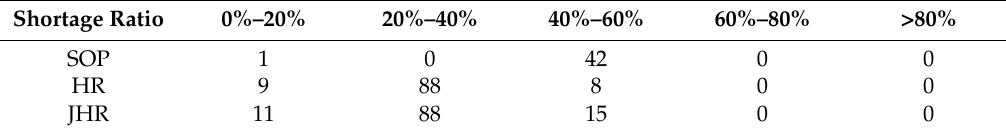
Table 6. Number of different water shortage in ( m , xd ) case.